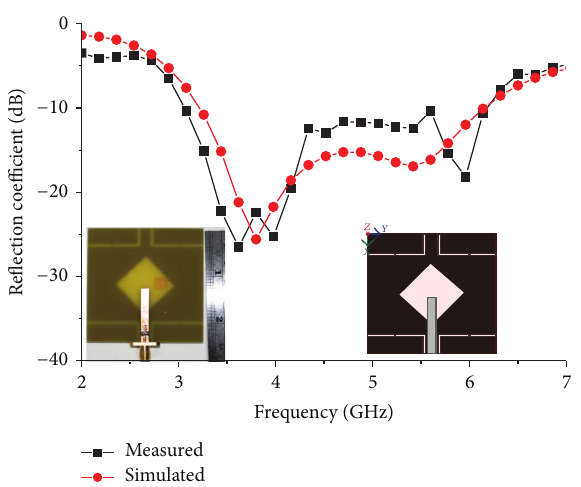
Figure 16: Measured gain of the proposed